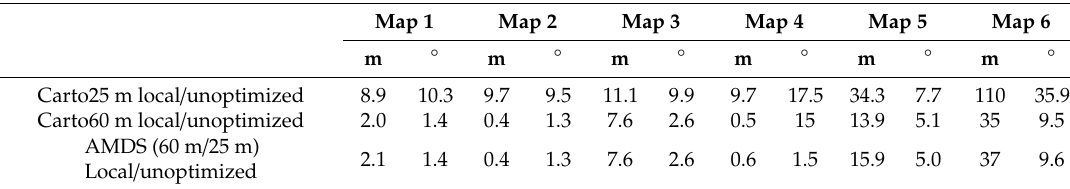
Table 4. Measured drift error translation (m) and rotation ( ◦